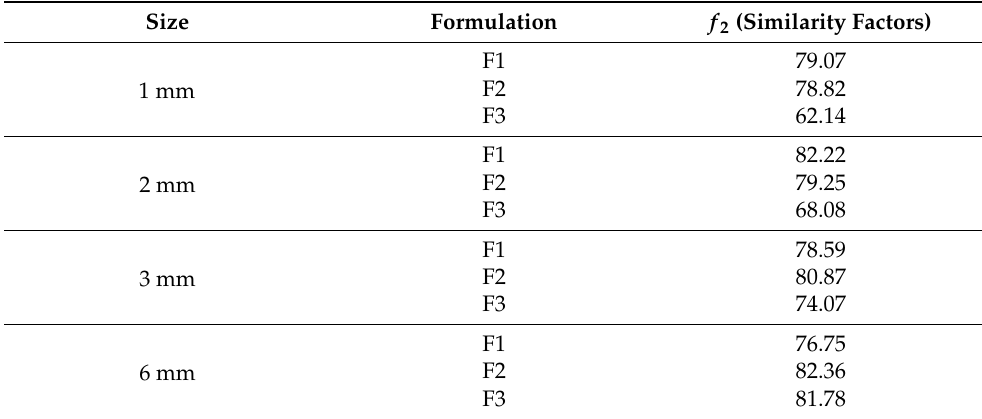
Table 5. Similarity factors of pellets with different size and formulation after stability